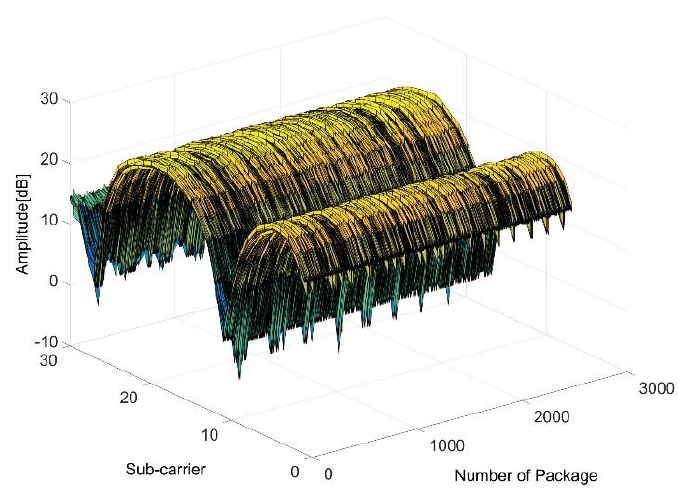
Figure 2. Raw WCI (wireless channel information) for human coughing.